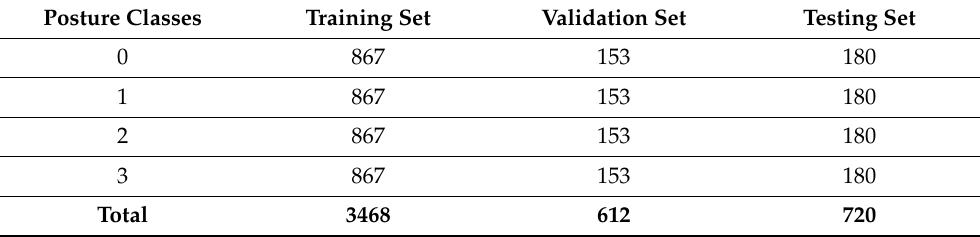
Figure 1. Human posture recognition for the four data sets (0 = bending, 1 = lying, 2 = sitting, and 3 = standing). Table 2. Data Split.